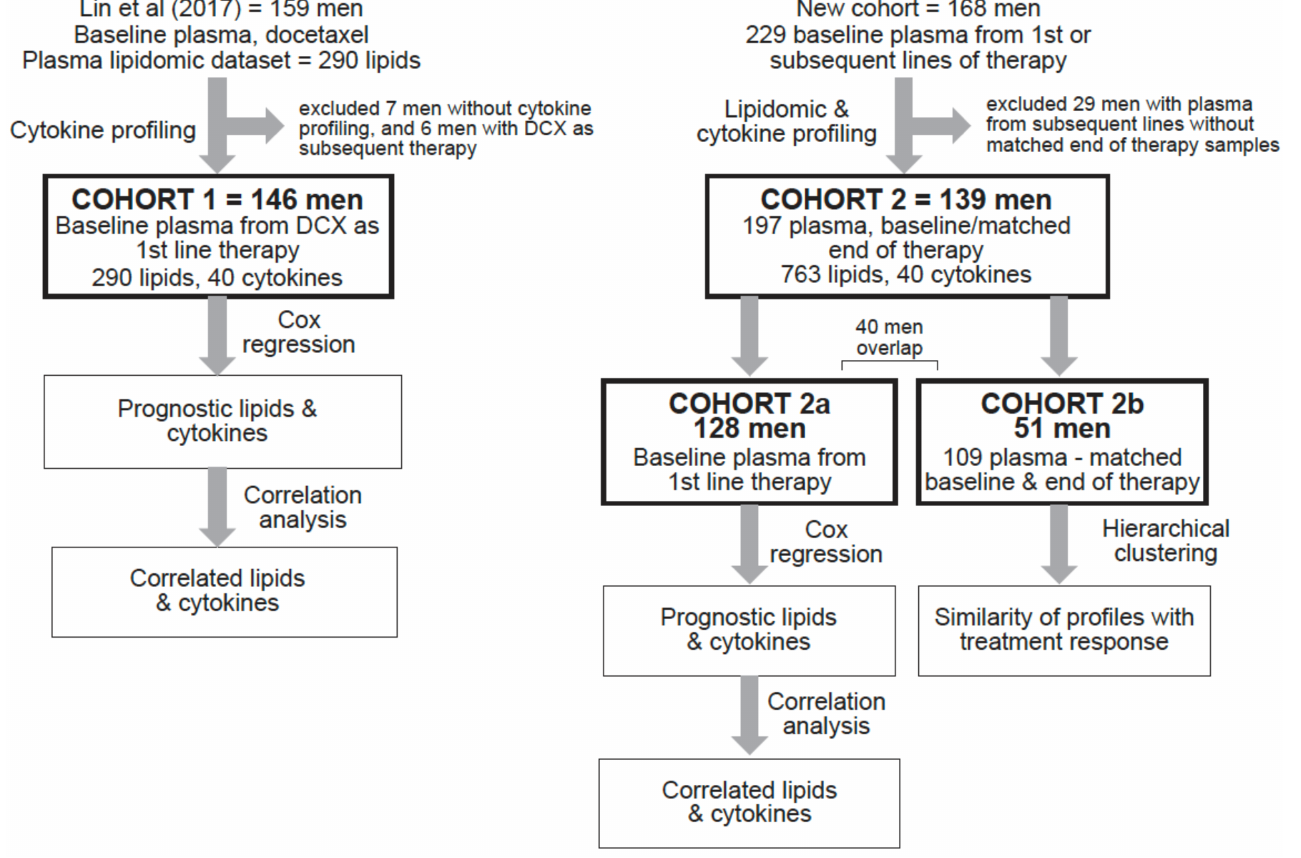
Figure 1. Study cohorts and schema (DCX,